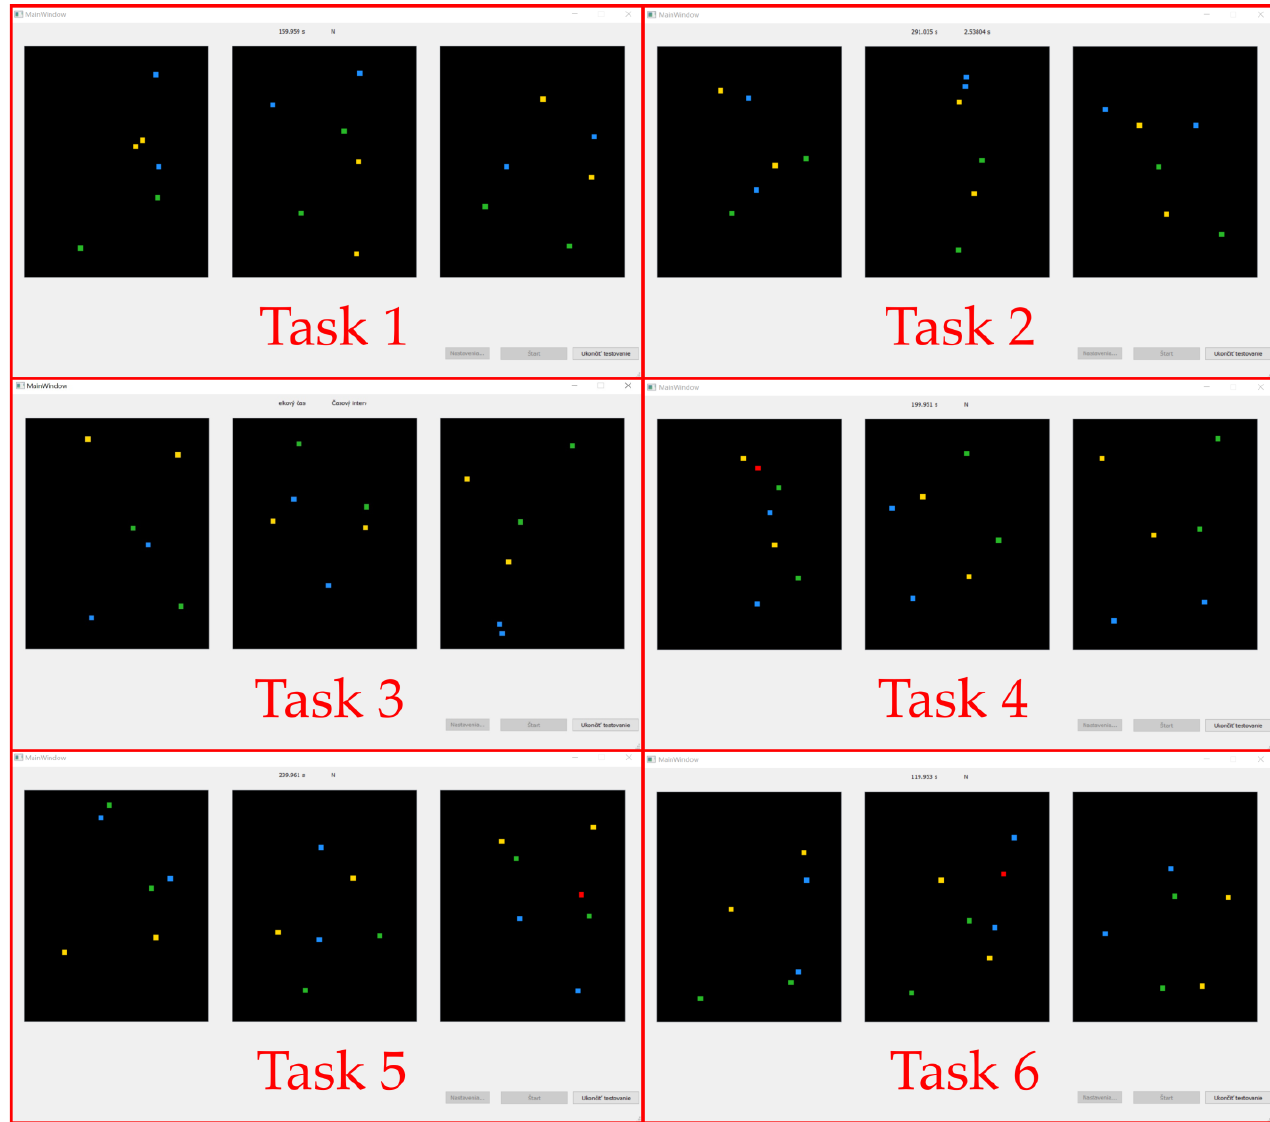
Task 6—in Sector 1, Sector 2, and Sector 3, three pairs of dots (yellow, green, blue)